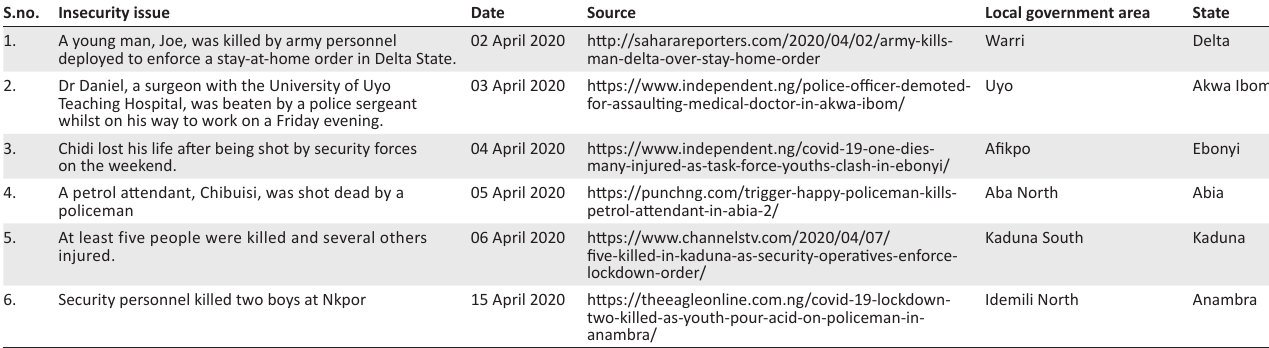
TABLE 1: Cases of human rights abuse by security